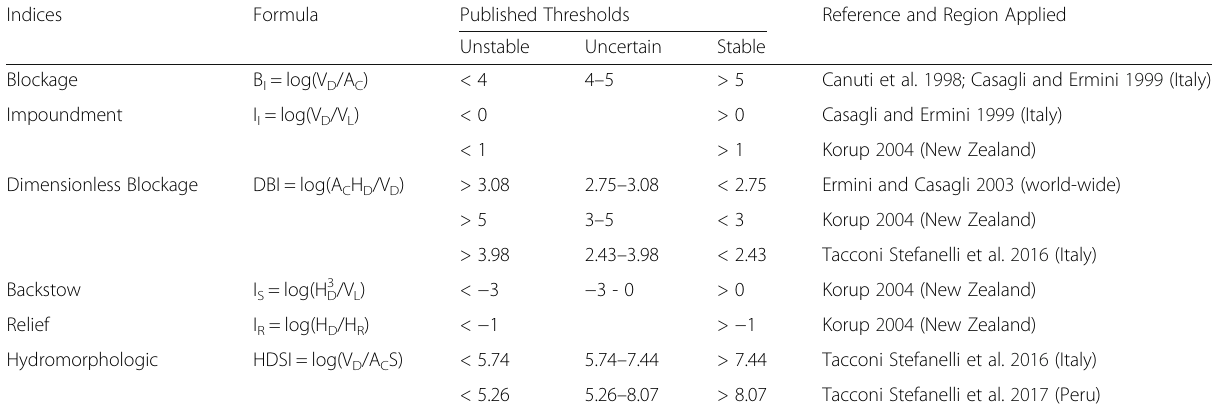
Table 3 Landslide dam stability assessment indices assessed against the recorded behaviour of the Peace River regional landslide dams